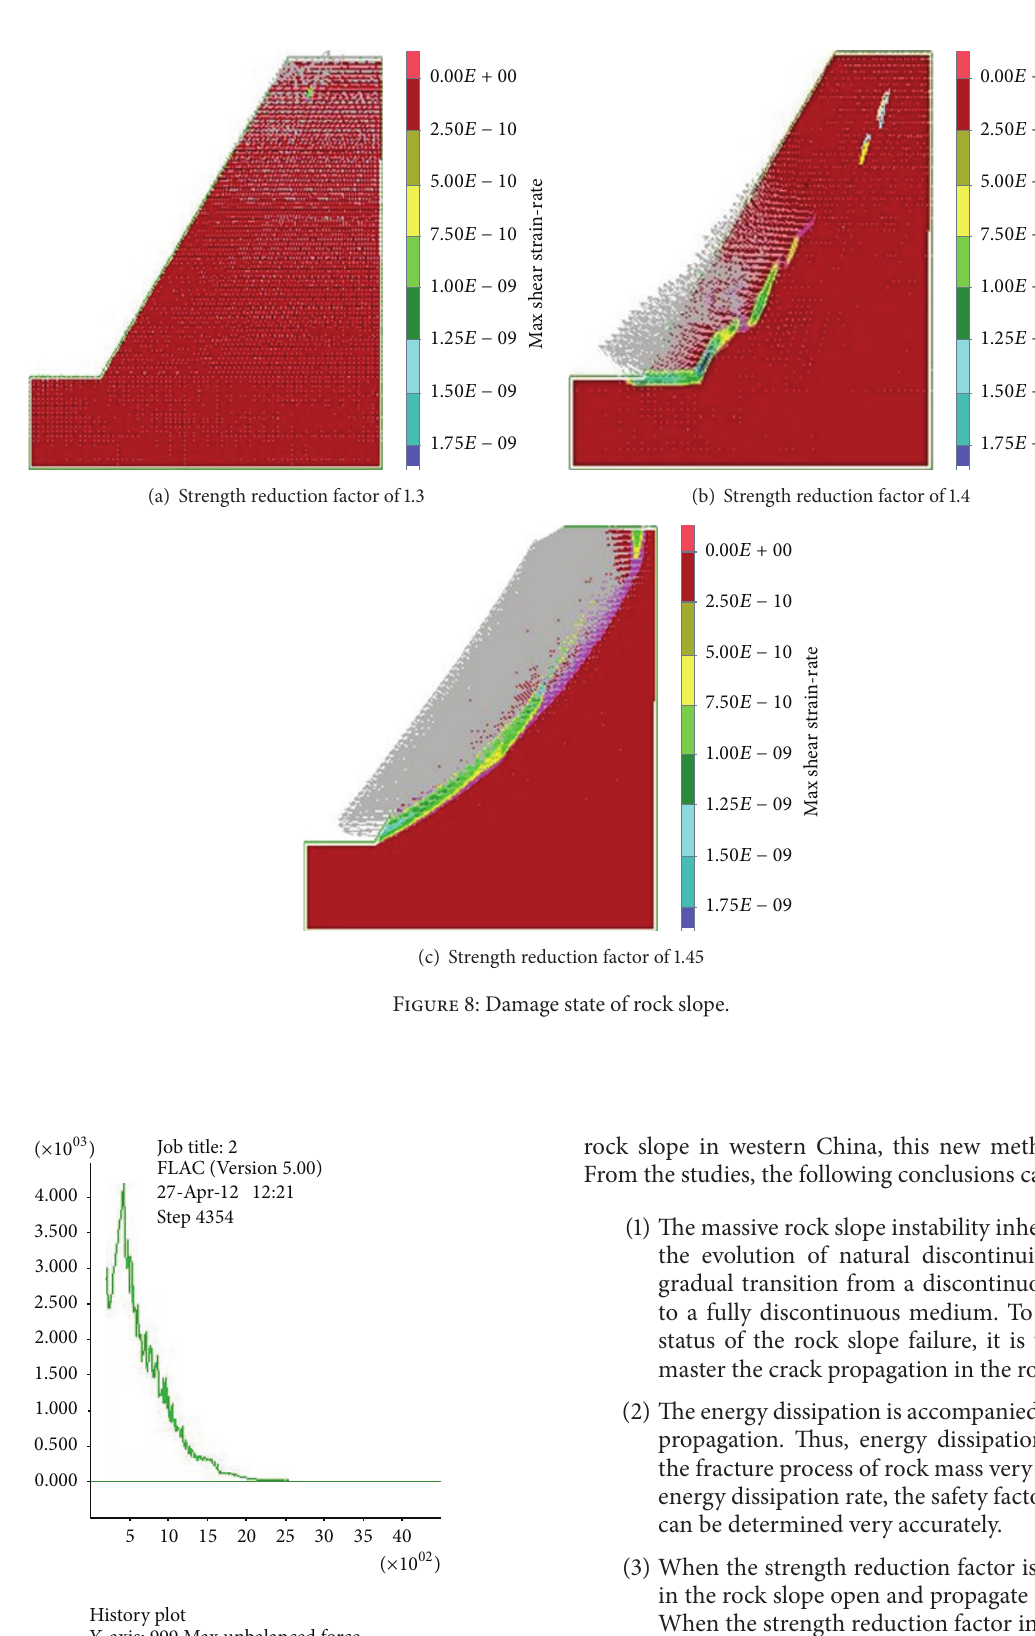
Figure 9: Curve of unbalanced force for the rock slope system.